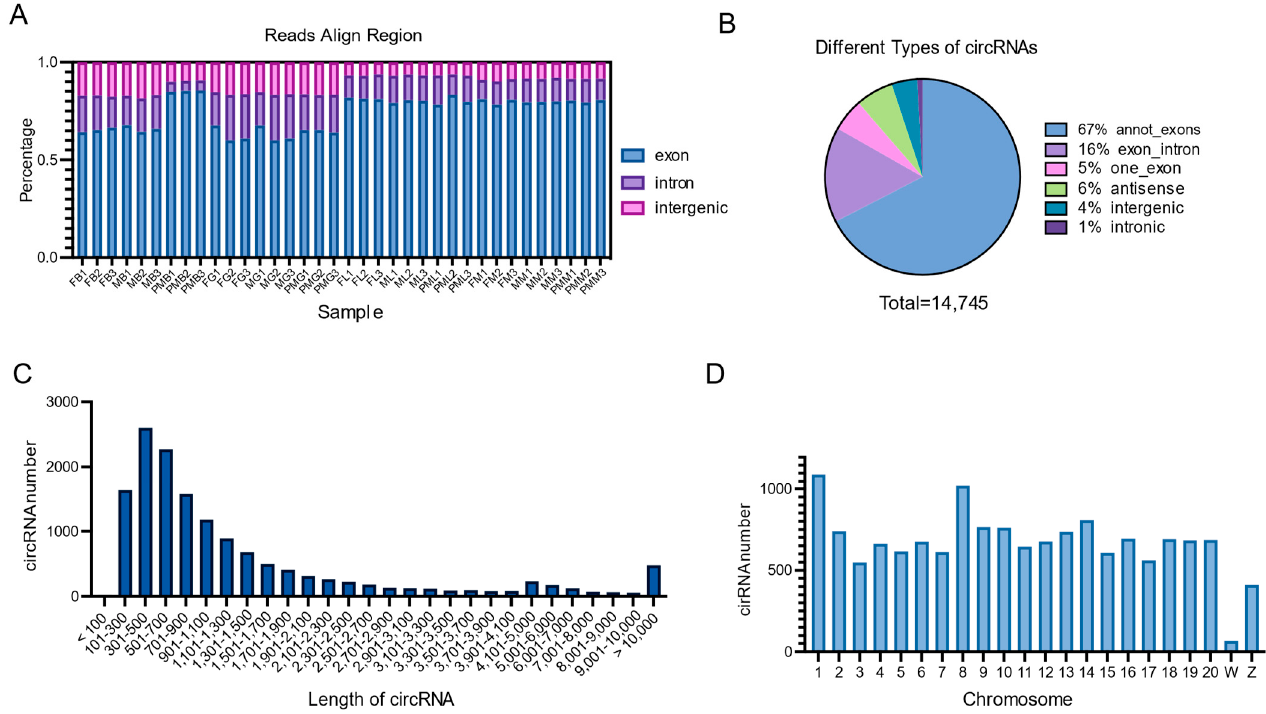
Figure 1. Identification and analysis of circRNAs. ( A ) CircRNA reads align regions in different samples. ( B ) Different types of circRNAs. ( C ) Length of circRNAs. ( D ) CircRNAs numbers of different Chromosomes.